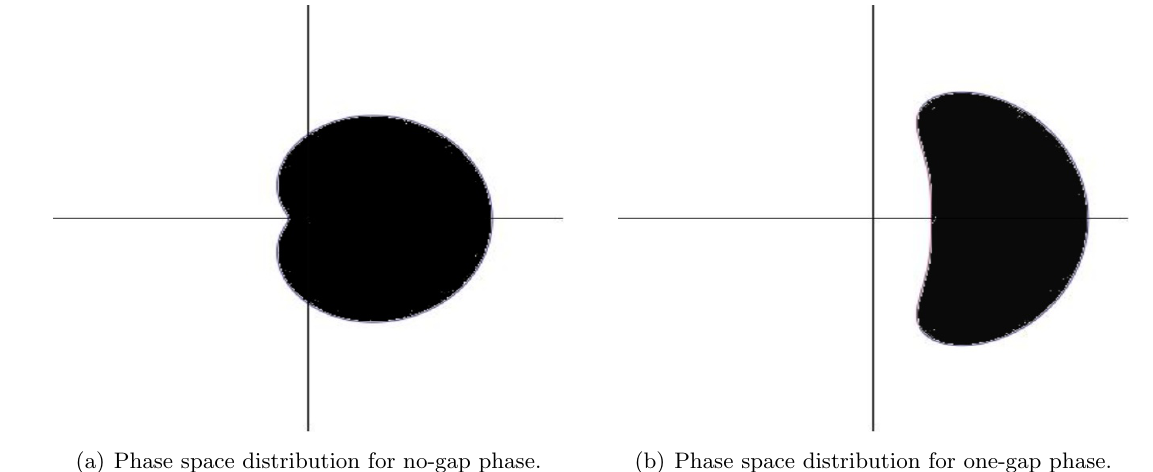
Figure 4 . Phase space distribution for generic GWW matrix model.